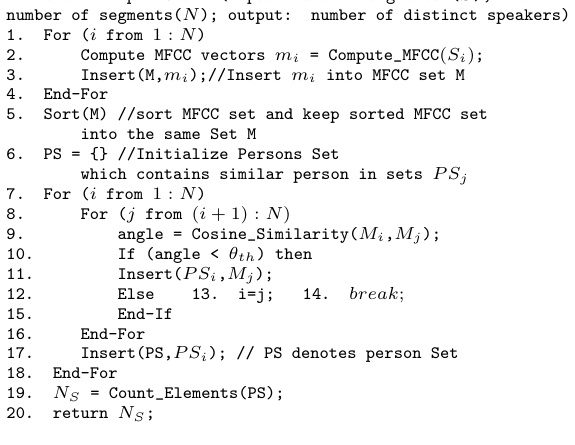
pseudo code of our proposed people counting heuristic has been shown in Fig.